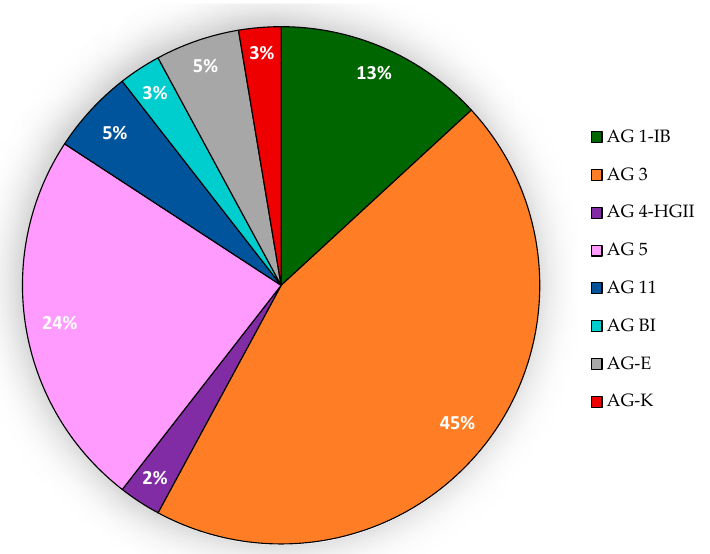
Figure 6. The distribution of AGs among the isolates sampled from carrot in the different Swedish areas.